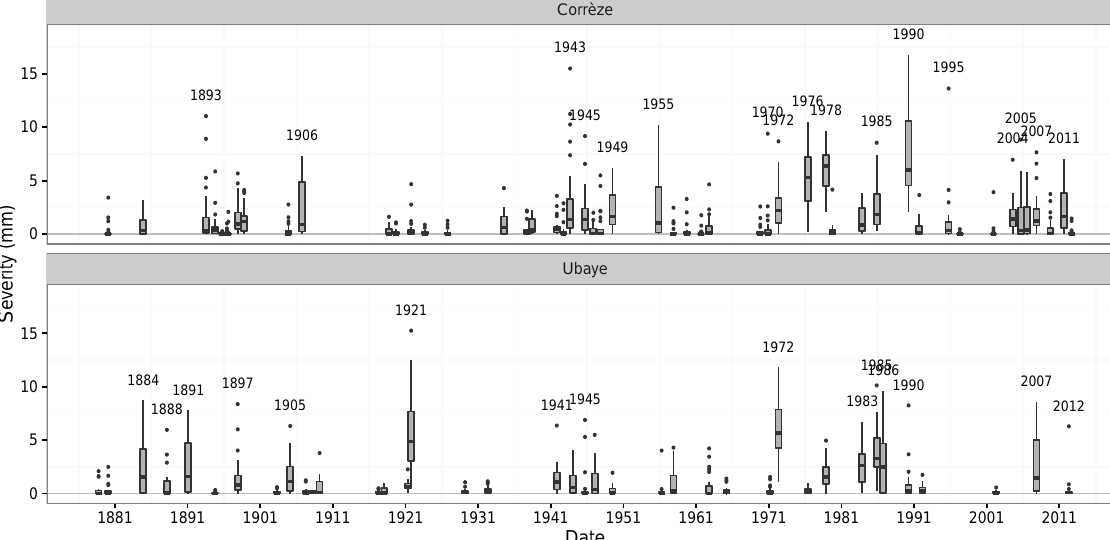
Figure 12. As for Fig. 11 but for severity (in millimetres).